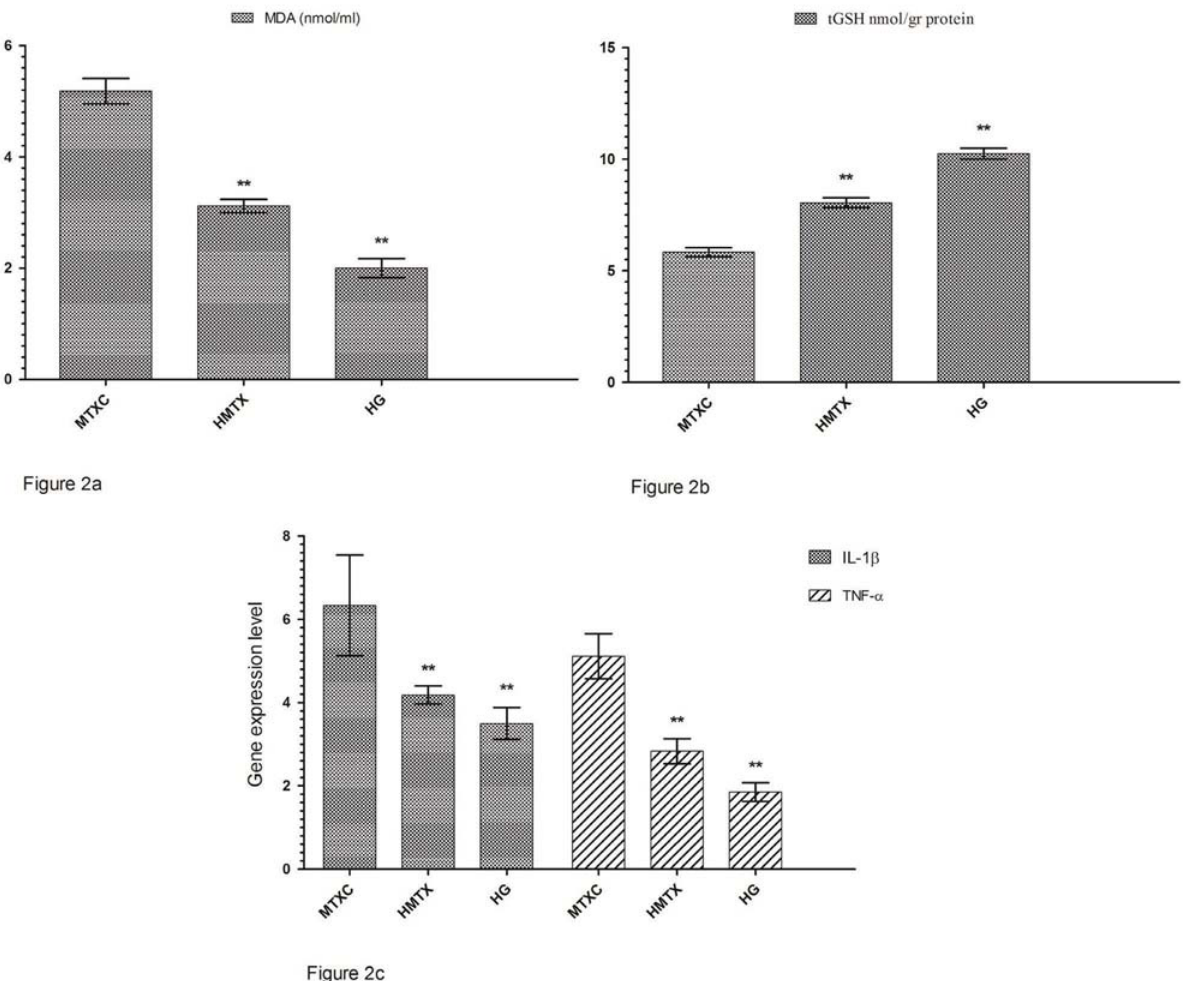
Figure 2- a: The effects of methotrexate on malondialdehyde (MDA) levels in the lower lip tissues; b: The effects of (cid:80)(cid:72)(cid:87)(cid:75)(cid:82)(cid:87)(cid:85)(cid:72)(cid:91)(cid:68)(cid:87)(cid:72)(cid:3)(cid:82)(cid:81)(cid:3)(cid:87)(cid:42)(cid:54)(cid:43)(cid:3)(cid:79)(cid:72)(cid:89)(cid:72)(cid:79)(cid:86)(cid:3)(cid:76)(cid:81)(cid:3)(cid:87)(cid:75)(cid:72)(cid:3)(cid:79)(cid:82)(cid:90)(cid:72)(cid:85)(cid:3)(cid:79)(cid:76)(cid:83)(cid:3)(cid:87)(cid:76)(cid:86)(cid:86)(cid:88)(cid:72)(cid:86)(cid:30)(cid:3)(cid:70)(cid:29)(cid:3)(cid:55)(cid:75)(cid:72)(cid:3)(cid:72)(cid:73)(cid:73)(cid:72)(cid:70)(cid:87)(cid:86)(cid:3)(cid:82)(cid:73)(cid:3)(cid:80)(cid:72)(cid:87)(cid:75)(cid:82)(cid:87)(cid:85)(cid:72)(cid:91)(cid:68)(cid:87)(cid:72)(cid:3)(cid:82)(cid:81)(cid:3)(cid:44)(cid:47)(cid:16)(cid:20)(cid:533)(cid:3)(cid:74)(cid:72)(cid:81)(cid:72)(cid:3)(cid:72)(cid:91)(cid:83)(cid:85)(cid:72)(cid:86)(cid:86)(cid:76)(cid:82)(cid:81)(cid:3)(cid:79)(cid:72)(cid:89)(cid:72)(cid:79)(cid:3)(cid:76)(cid:81)(cid:3)(cid:87)(cid:75)(cid:72)(cid:3) lower lip tissues.